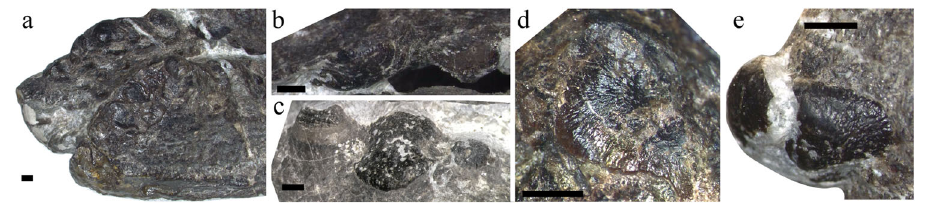
Fig. 8 Photo showing the tooth details of Sclerocormus cf. S. parviceps (HFUT MJS-16-012). a Dentary dentition in left lateral view. b Maxillary dentition in ventral view. c Dentary dentition in dorsal view. d Close-up of the enamel surface morphology. e The tip of the fi rst maxillary tooth. Note the ‘ orange- peel-like ’ pitting of the enamel surface in b , c and e . Scale bars equal 2 mm.